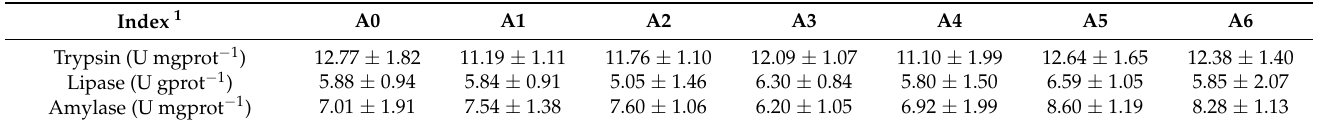
Table 6. Effects of Yarrowia lipolytica on digestive enzyme activities in intestinal tissues of Litopenaeus vannamei ( n =